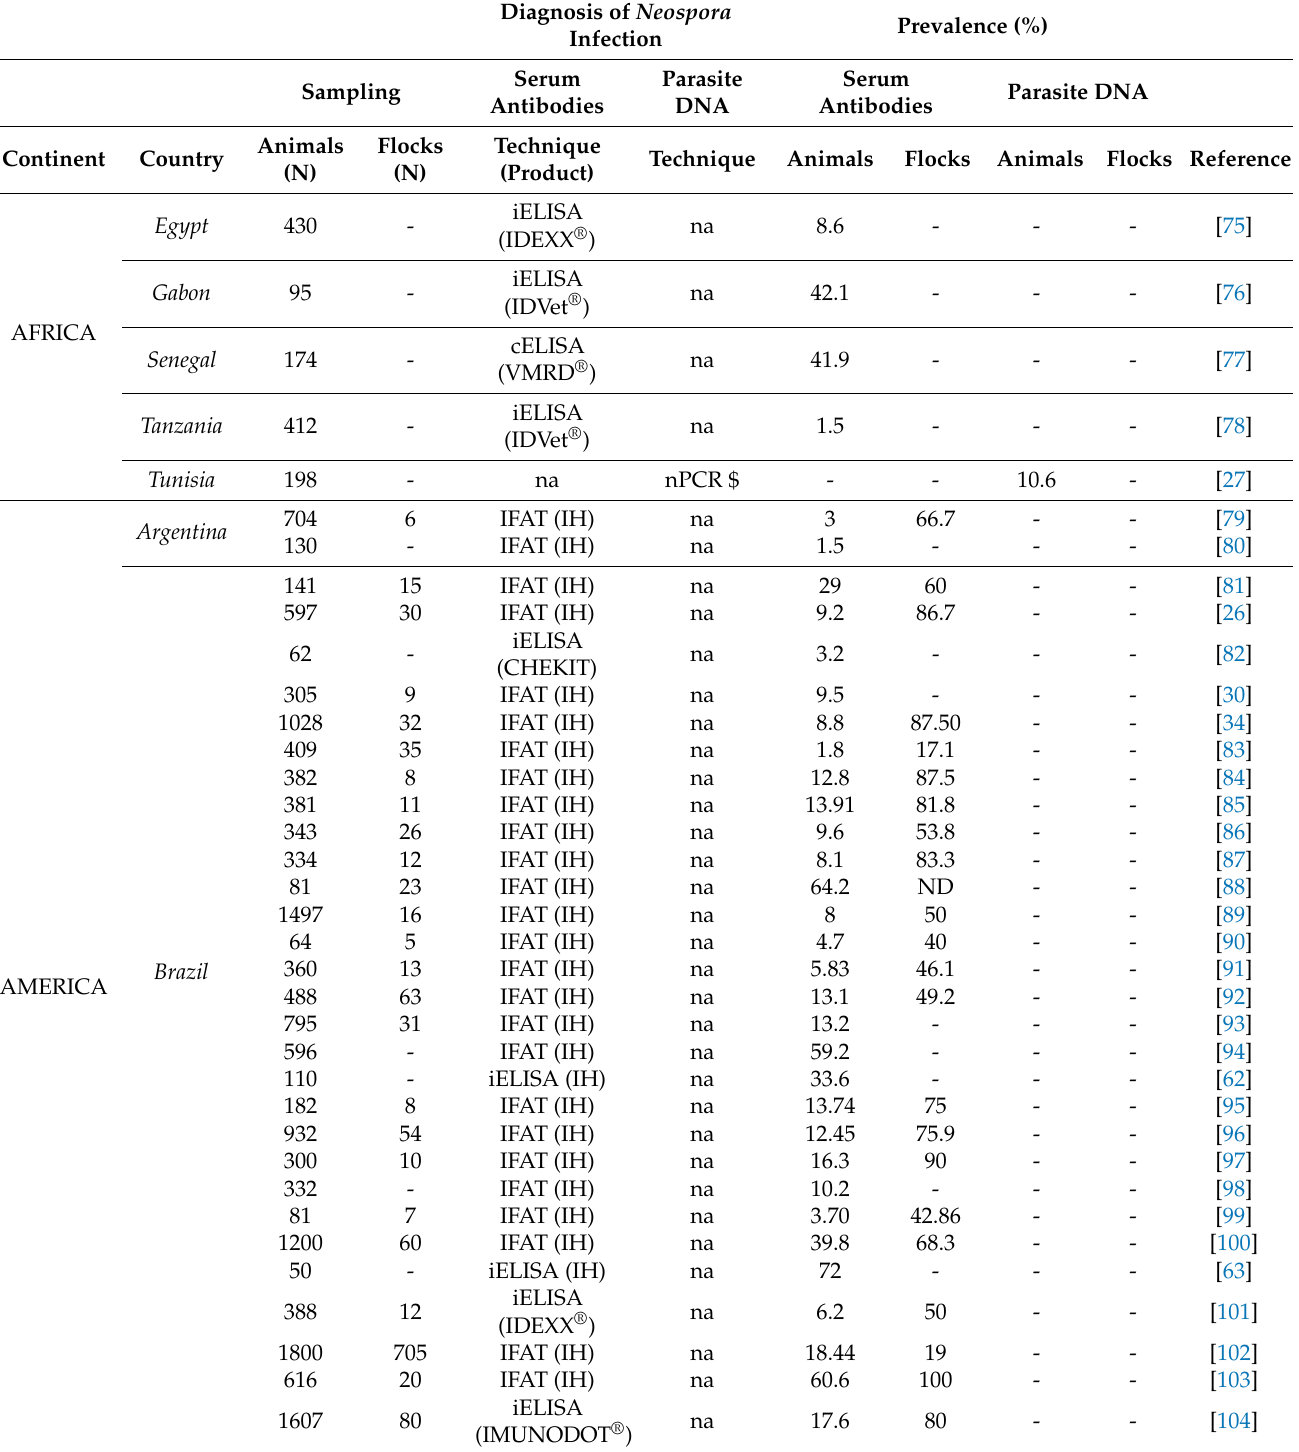
Table 1. Large-scale prevalence studies conducted worldwide on ovine neosporosis